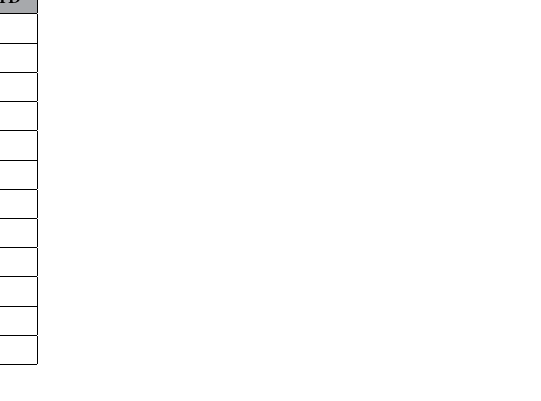
Table 1. Patient